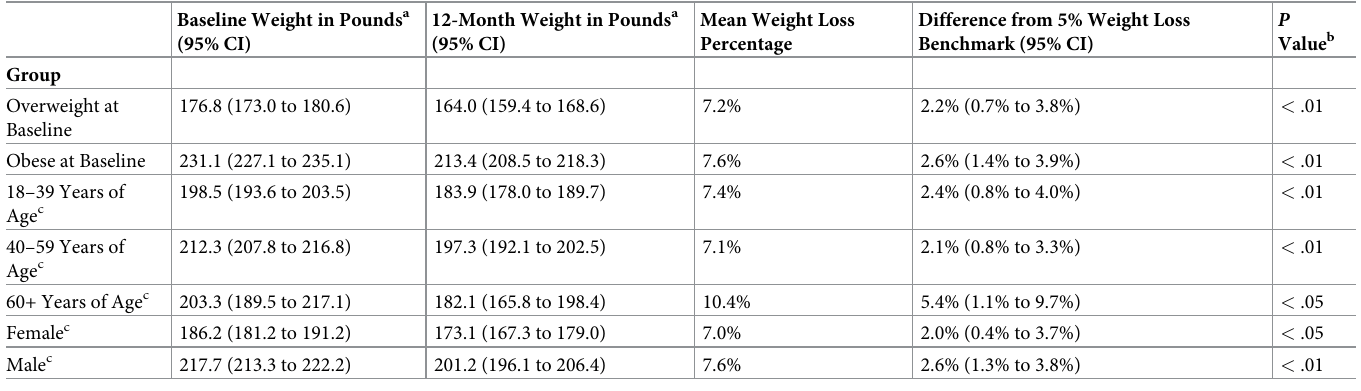
Table 2. Weight outcomes by baseline BMI category and demographic